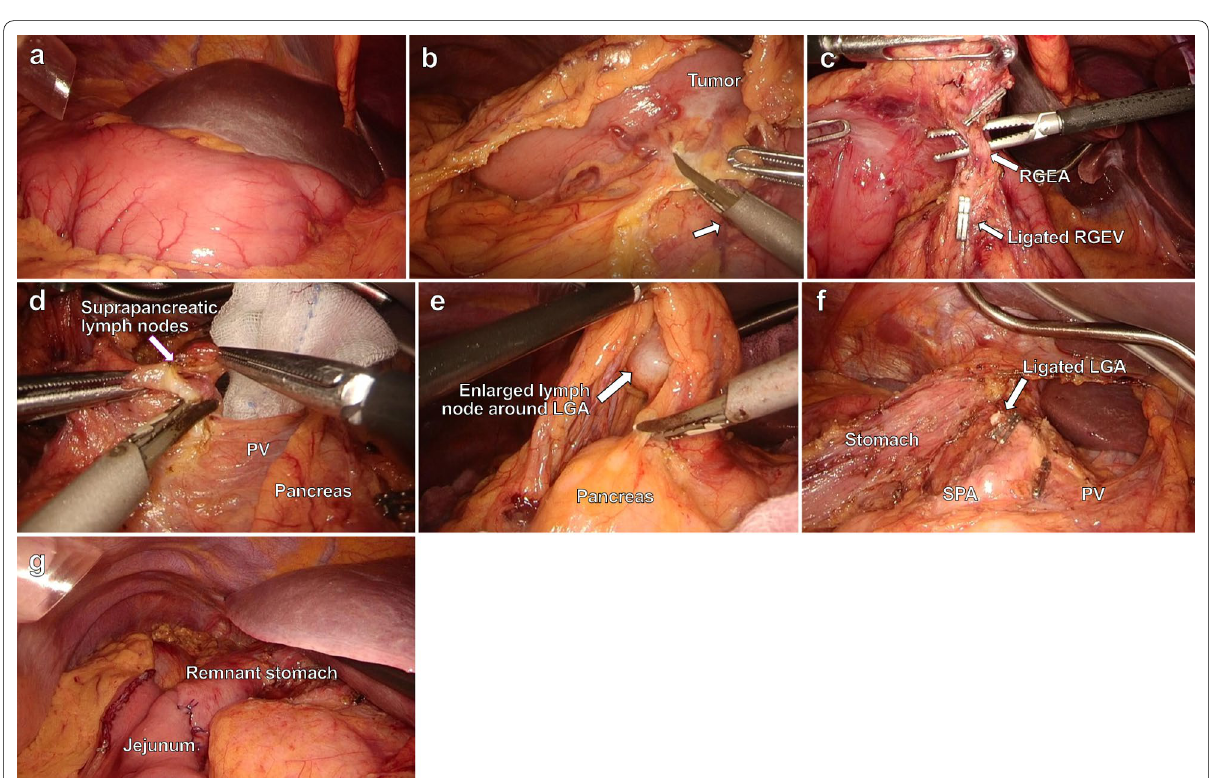
Fig. 4 Intraoperative findings during laparoscopic distal gastrectomy. a Laparoscopic view showing inversion of the abdominal organs. b The energy device was used by the non-dominant hand of this operator (arrow). c In the infrapyloric area, RGEV and RGEA were ligated, respectively. d On the left side of the suprapancreatic area, the anatomical landmarks of lymph node dissection were the upper border of the pancreas, PV. e Enlarged lymph node of 3 cm in diameter was found around the LGA. f Completion of lymph node dissection in the suprapancreatic area and lesser curvature side of the stomach. g Roux-en-Y reconstruction. RGEV right gastroepiploic vein, RGEA right gastroepiploic artery, LGA left gastric artery, PV portal vein, SPA splenic